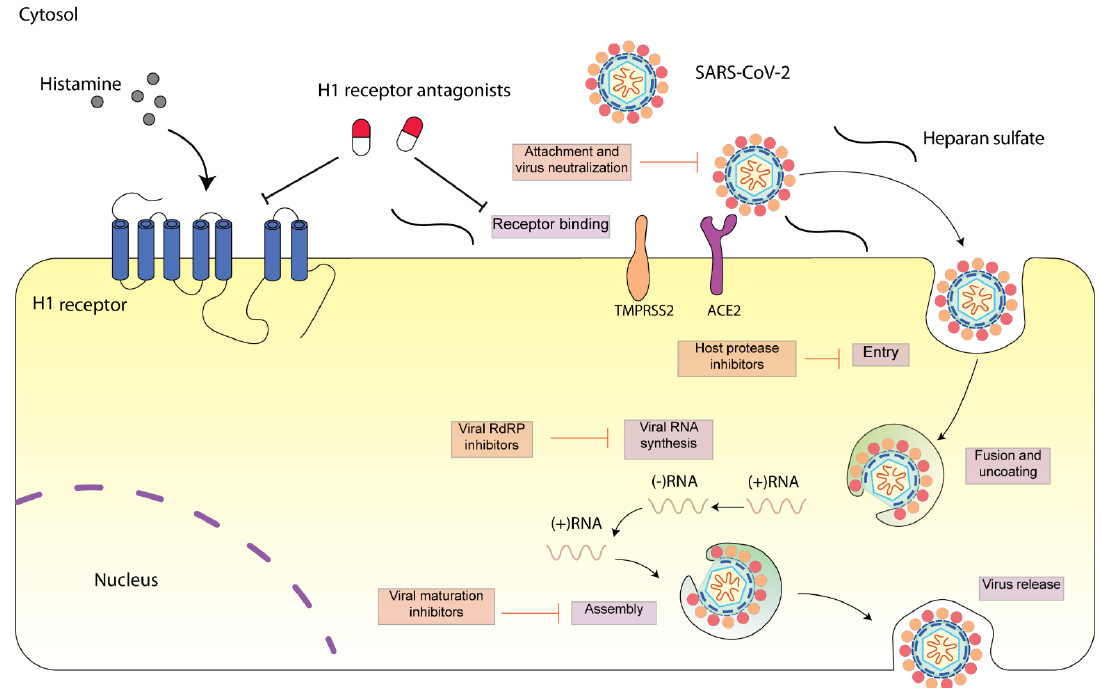
Figure 1. Schematic diagram presenting life cycle of SARS-CoV-2 and relevant inhibitors. SARS-CoV-2 cell entry begins with binding of the spike S protein to ACE2, a process that is facilitated by TMPRSS2. SARS-CoV-2 enters the cell through endocytosis, and then the virus is uncoated in the acidic environment of lysosomes. After that, SARS-CoV-2 RNA is released, followed by the reproduction of virus genome and viral proteins. Then, the viral components are assembled and released via exocytosis [15]. Each step can be targeted by relevant inhibitors. H1 receptor antagonists may inhibit SARS-CoV-2 either via H1 receptor or via ACE2 receptor. SARS-CoV-2 spike protein interacts with both cellular heparan sulfate and ACE2 through its receptor-binding domain (RBD) [16]. H1 receptor antagonists may disrupt the interaction between heparan sulfate and spike protein, inhibiting SARS-CoV-2 entry.